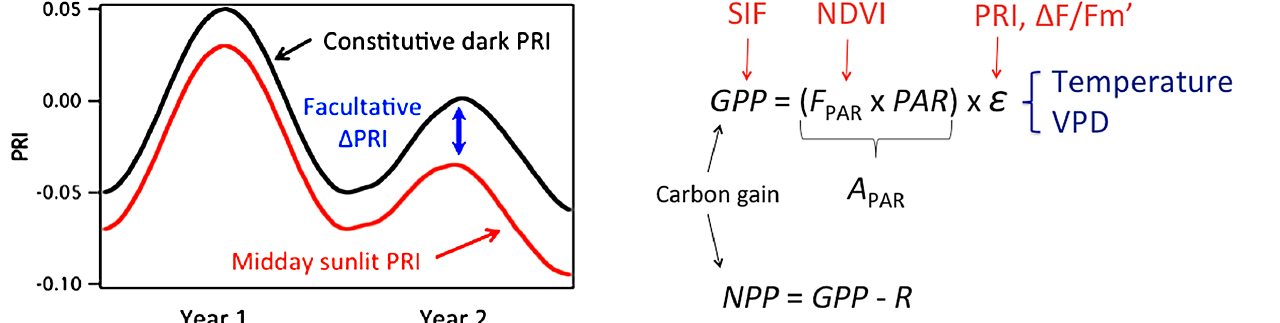
Figure 4. Illustration of constitutive (pigment pool size) and fac- ultative (xanthophyll cycle) effects on PRI time series, represent- ing two annual cycles of PRI for evergreen vegetation. In this case, the dominant cause of PRI variation is the constitutive adjustment in chlorophyll:carotenoid ratios across seasons, with less variation due to the diurnal xanthophyll cycle operation ( (cid:49) PRI), a facultative process that further modulates light energy distribution (Fig. 1). In year two, chronic stress (e.g., drought) causes reduction in the con- stitutive component (dark-state PRI) along with additional adjust- ments of the facultative component ( (cid:49) PRI). Adapted from Sims et al., 2006 and Wong and Gamon (2015a).